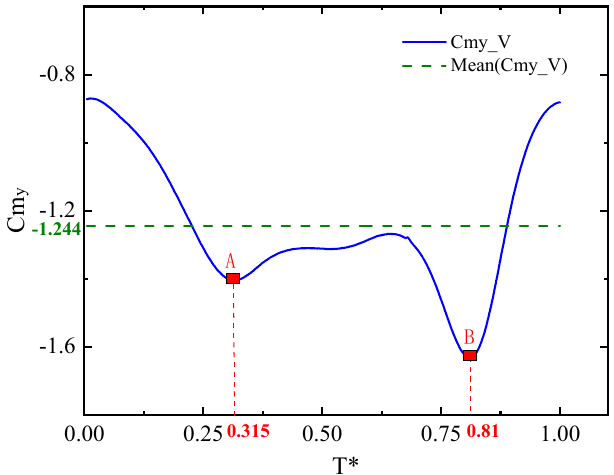
Figure 23. The pitch moment changes of the inverted V-tail.